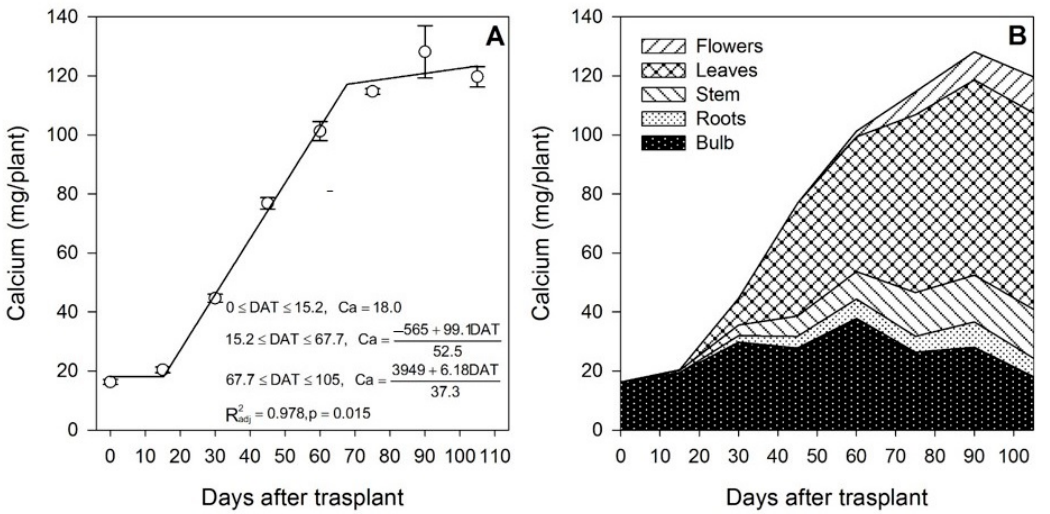
Figure 5. Calcium accumulation in lilium: ( A ) Segmented analysis of calcium accumulation over the growing season; ( B ) Calcium distribution in the lilium plant parts. Day 0 = transplant day, days 0 to 15 = sprouting and initial vegetative growth, days 15 to 60 = rapid vegetative growth plus flower buds formation, days 60 to 105 = blooming. DAT = days after transplant.